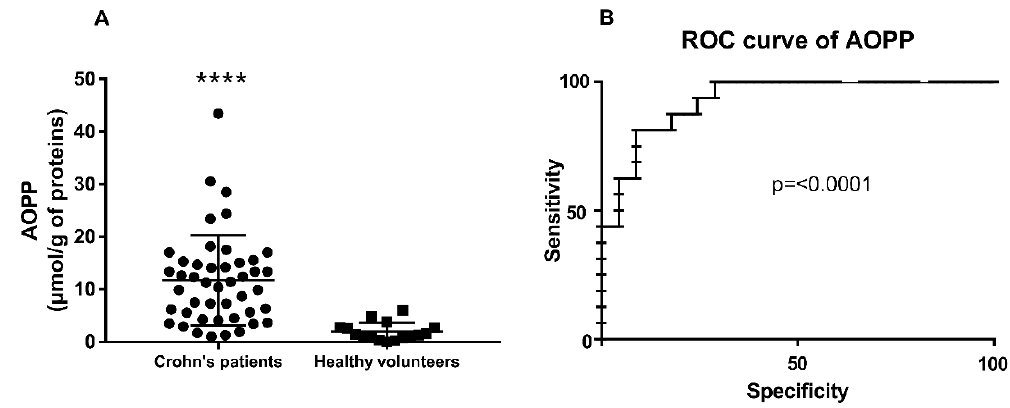
Figure 1. ( A ) Scatter dot plot of the advanced oxidation protein products (AOPP) levels in the serum of Crohn’ patients and healthy volunteers. **** p < 0.0001 by Mann–Whitney test. ( B ) ROC curve for AOPP.